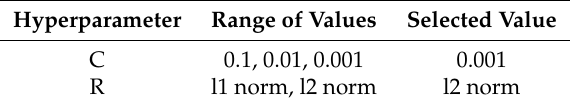
Table 3. LR hyperparameters selected through grid-search.